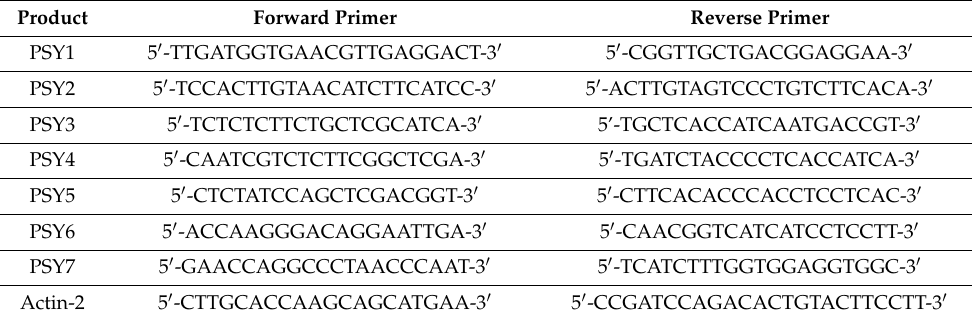
Table 1. Primer sequences used for qPCR.